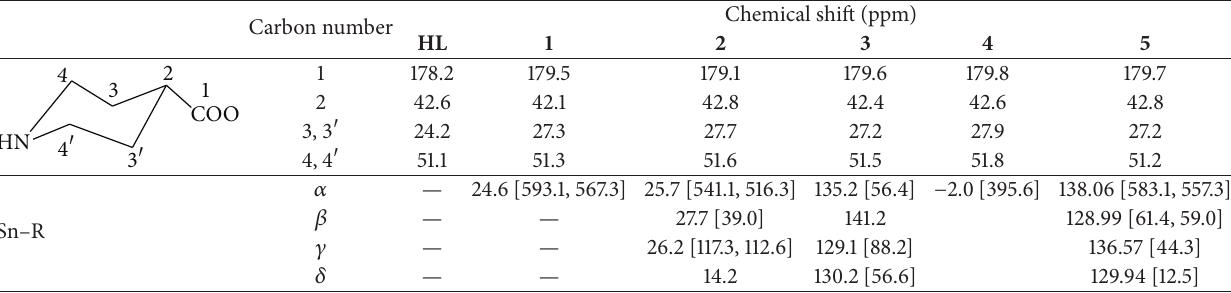
Table 5: 13 C NMR data a of organotin complexes 1–5 .